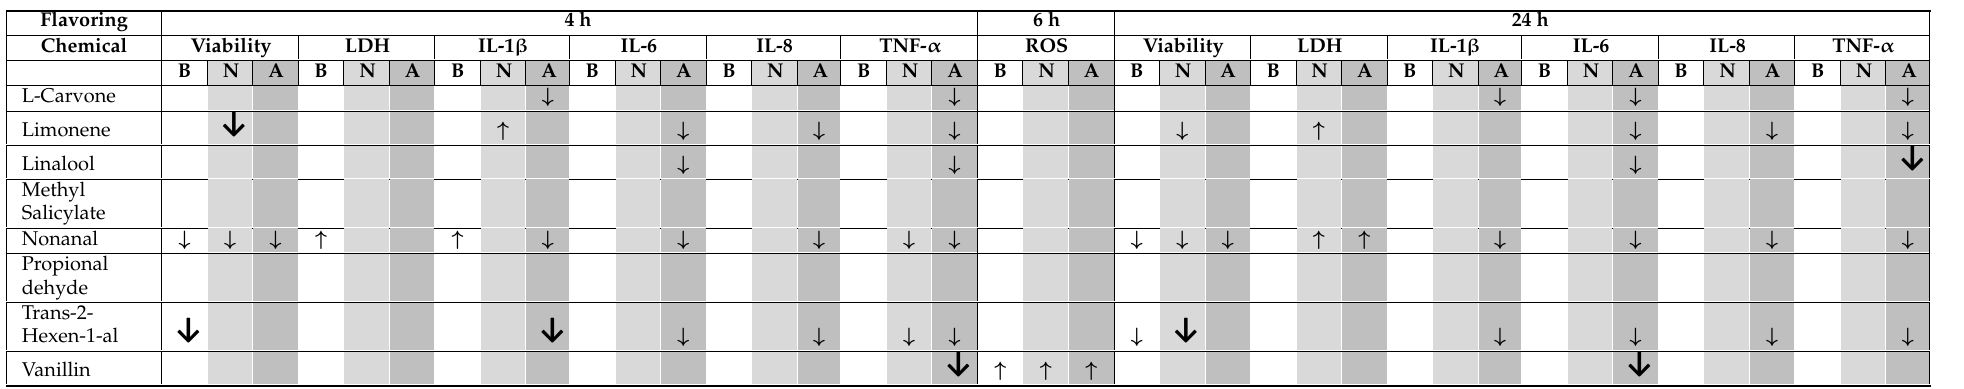
Table 2. Results summary expressing magnitude of change compared to vehicle control. B = BEAS ‐ 2B, N = Naïve THP ‐ 1, A = Activated THP ‐ 1. Arrows indicate significant difference ( p < 0.05) to control: low decrease (small down arrow), twofold or greater decrease (large down arrow), low increase (small up arrow), twofold or greater increase (large up arrow).